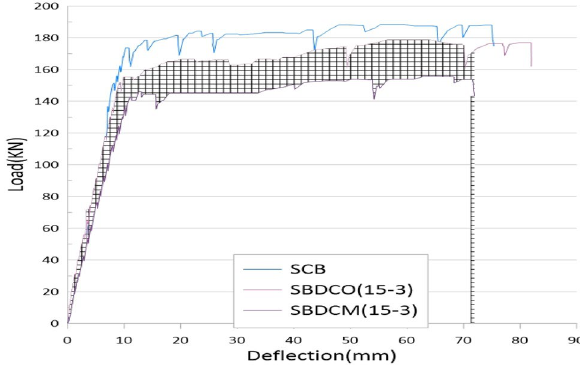
Fig. 8 Load–displacement diagrams in specimens having the same